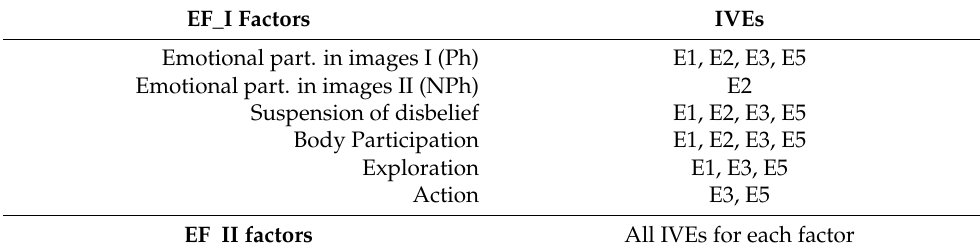
Table 3. Association between IVEs and the engagement evaluation